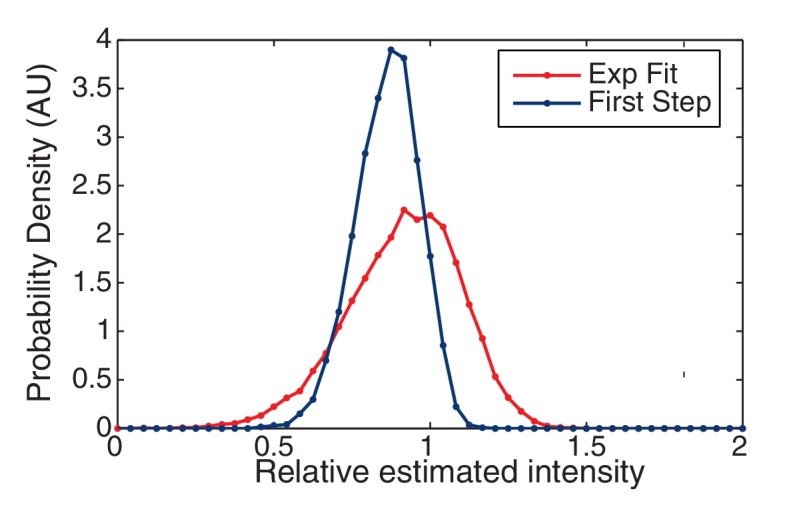
Finding the initial intensity.We simulated two approaches for determining the initial intensity of the trace: Exponential Fit and Highest-Level. The probability of the estimated intensity is shown relative to the true initial intensity. The Highest Level method is clearly biased from below relative to the Exponential Fit method which is centered around the true value (unity).